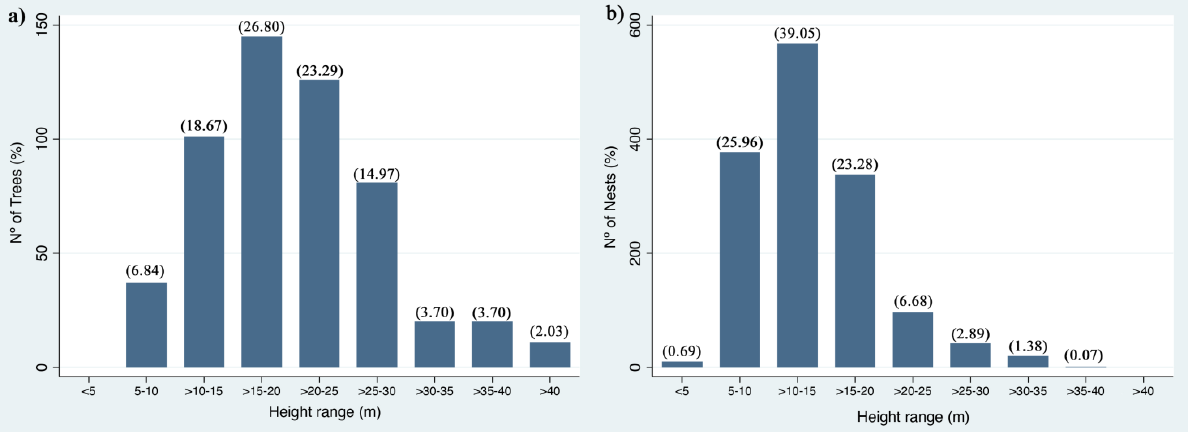
Figure 3. Box plots for height ranges of trees ( a ) and their Monk Parakeet nests ( b ) located between 2016 and 2019 in Santiago, Chile. Percentages shown between